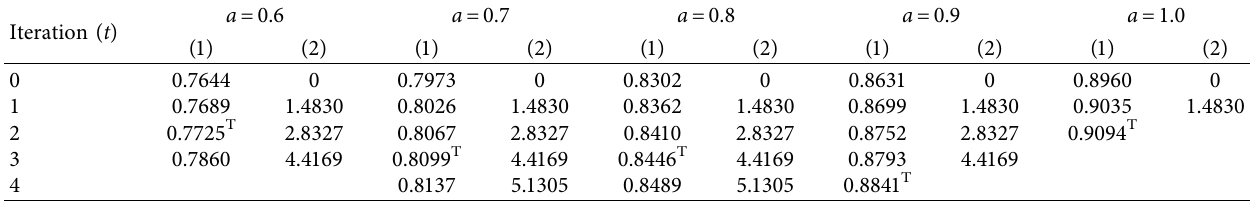
Table 24: .e group consensus levels and the adjustment costs of the different a .